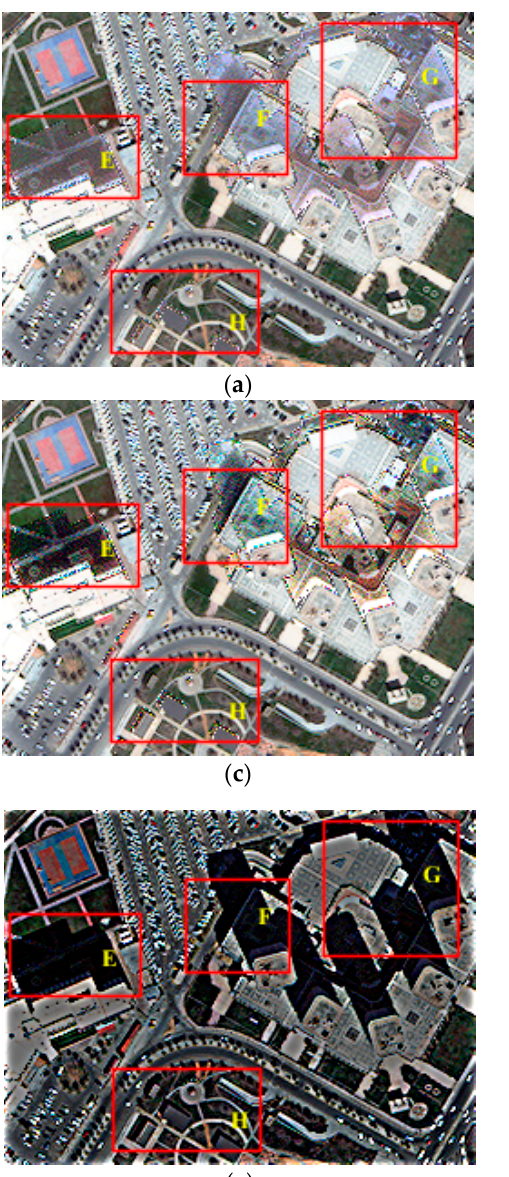
( f ) Figure 6. Shadow compensation results of various shadow compensation algorithms for the test image Tripoli-1. ( a ) The irradiance restoration based (IRB) method. ( b ) The linear correlation correction (LCC) method [16,21] . ( c ) The light source color rate (LSCR) method [33] . ( d ) The multi-scale Retinex (MSR) method [24,36] . ( e ) The homomorphic filtering (HF) method [25] . ( f ) The direct and environment light based method (DELM) [11,37] .